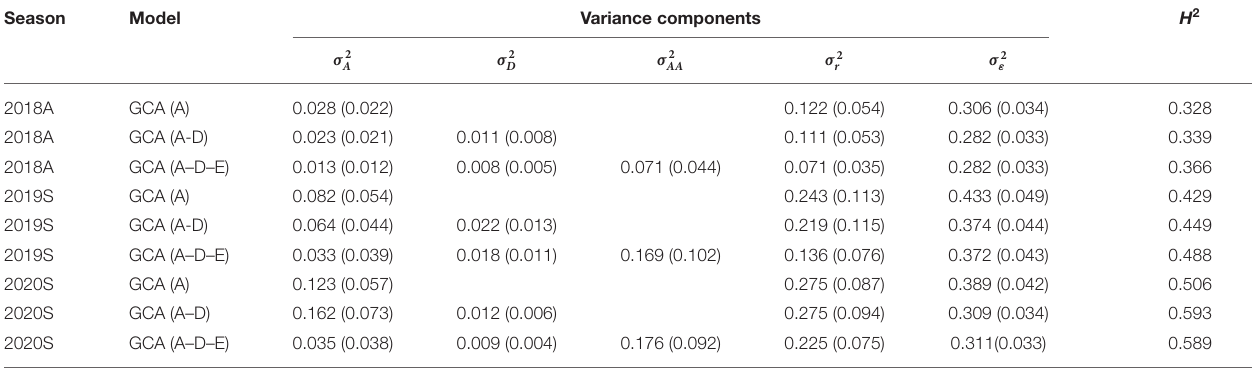
TABLE 2 | The estimated posterior of genetic variance components and broad-sense heritability ( H 2 ) under three GCA models for the cFY trait. Season Model